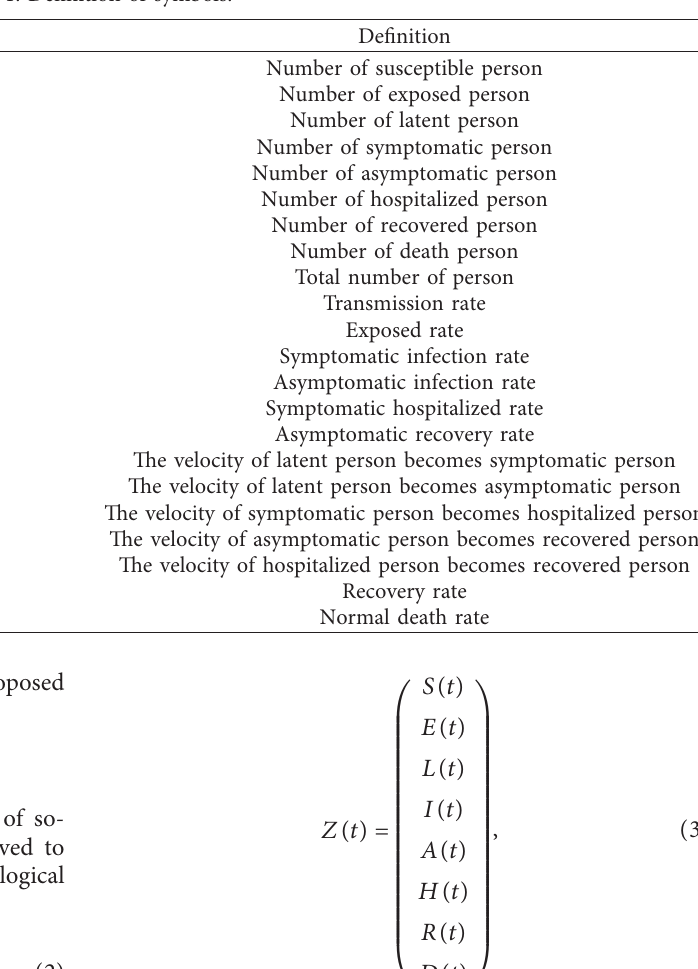
Table 1: Definition of